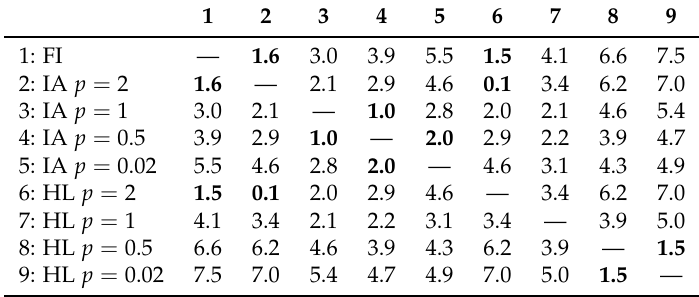
Table 8. Average Absolute Differences for Different Linking Methods for Reading Domain in PISA 2006 for 26 Selected OECD Countries. 1 2